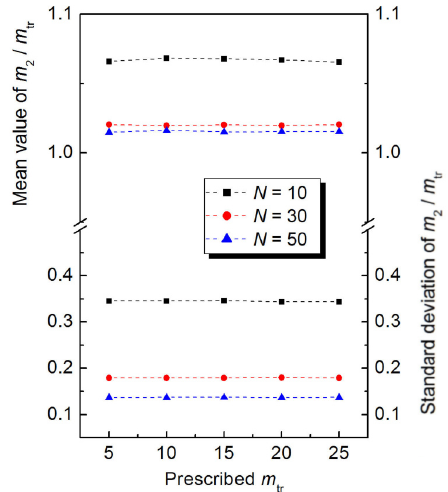
Fig. 3 Variations of the mean value of ( ) c for different sample value of v f